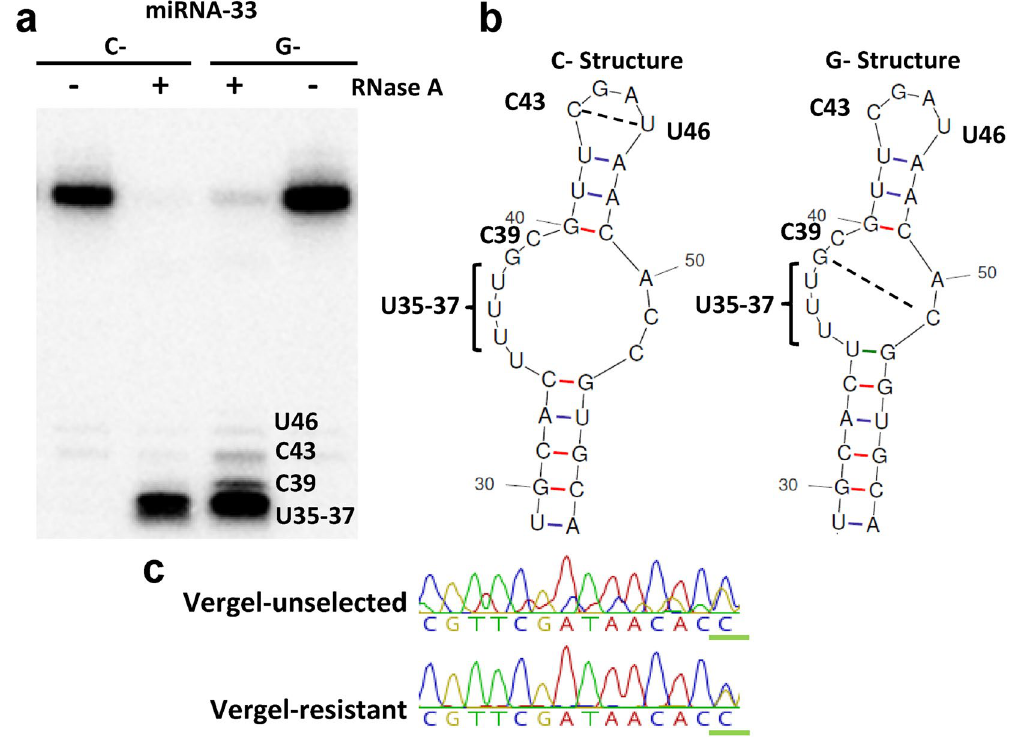
Figure 1. Secondary structures for pre-miR-33 hairpins were altered in the presence of a single nucleotide polymorphism. ( a ) RNAse A treatment of C-pre-miR-33 and G-pre-miR-33. Nucleotide positions were assigned using an RNA ladder as well as RNA partially digested using T1 RNAse to identify the positions of G residues. Data are representative of at least 3 technical replicates. ( b ) Alternative secondary structures with cleavable single-stranded RNA position numbers are noted. ( c ) Sanger sequencing of the pre-miRNA region of pools of 5 mosquitoes from each strain (Vergel-unselected (VU) and Vergel-resistant (VR)); G:C polymorphism is underlined in green. Raw blot is in Supplementary Fig. S2. Chromatograms were produced in Geneious (version 11.1 (Geneious.com)), with permission.